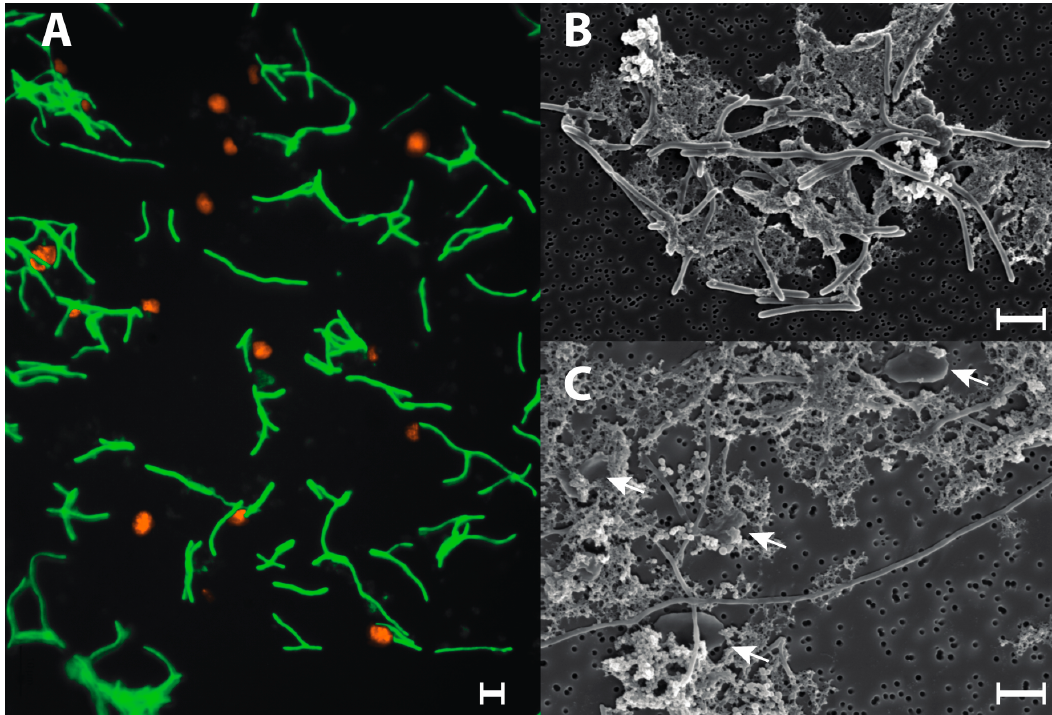
Figure 4. ( A ) Fluorescent in situ hybridization image of a stationary phase co-culture of V. guaymasensis L81 (labeled in green) and M. limicola (labeled in orange), utilizing glucose as substrate for growth; ( B ) Scanning electron micrograph of a stationary phase co-culture of V. guaymasensis L81, and M. limicola , given glucose; ( C ) Scanning electron micrograph (SEM) of a stationary phase co-culture of V. guaymasensis L81, and M. limicola , given crude oil. Arrows mark cells of M. limicola . Scale bars: 2 µm.